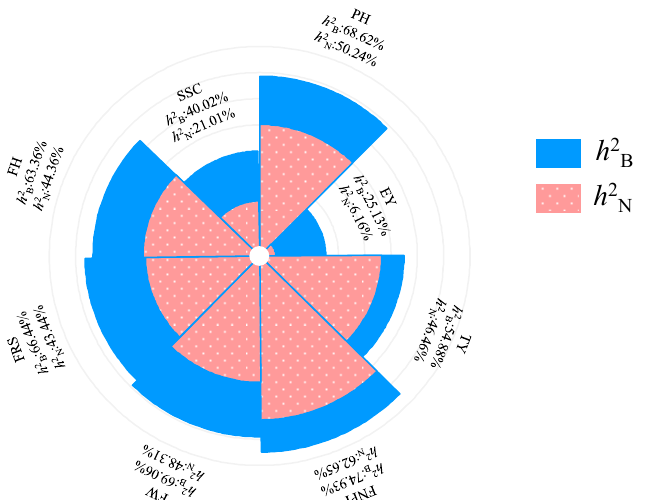
Figure 2. Analysis of heritability of different characters. h 2N —narrow heritability estimate, h 2B — broad heritability estimate.